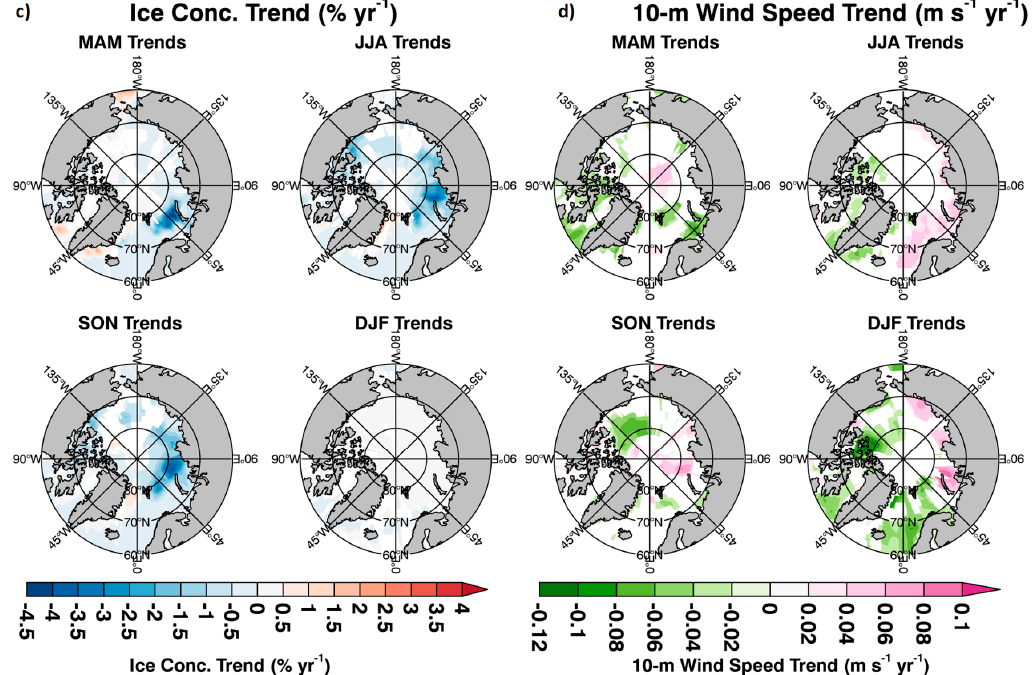
Figure 12. Panels show the observed, seasonal trends ( a ) T s –T a , ( b ) q s –q a , ( c ) sea ice concentration, and ( d ) 10-m wind speed across the Arctic between 2003 and 2015. Land regions are in gray and white shows trends that are not statistically significant at the 95% confidence level using a two-sided t -test.